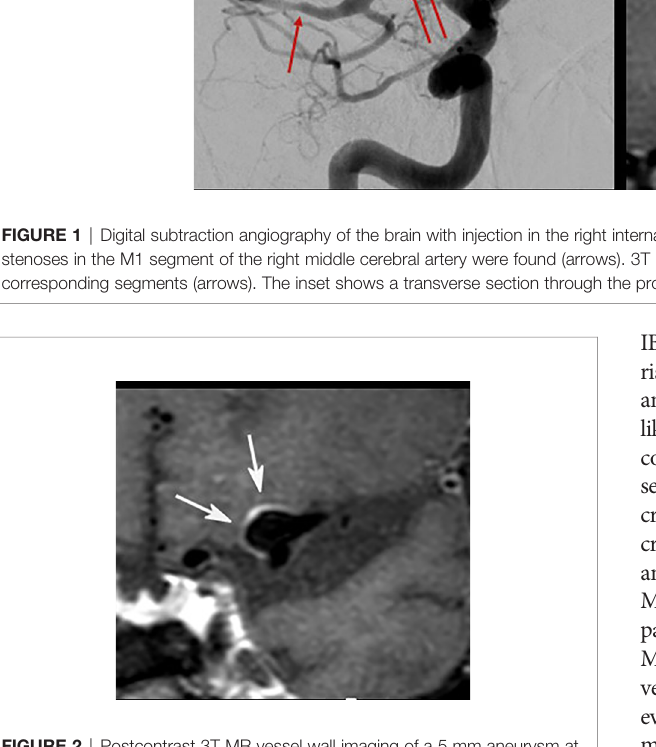
FIGURE 2 | Postcontrast 3T MR vessel wall imaging of a 5 mm aneurysm at the middle cerebral artery bifurcation. Note the strong wall enhancement (arrows) as a possible marker for visualization of wall in fl ammation.